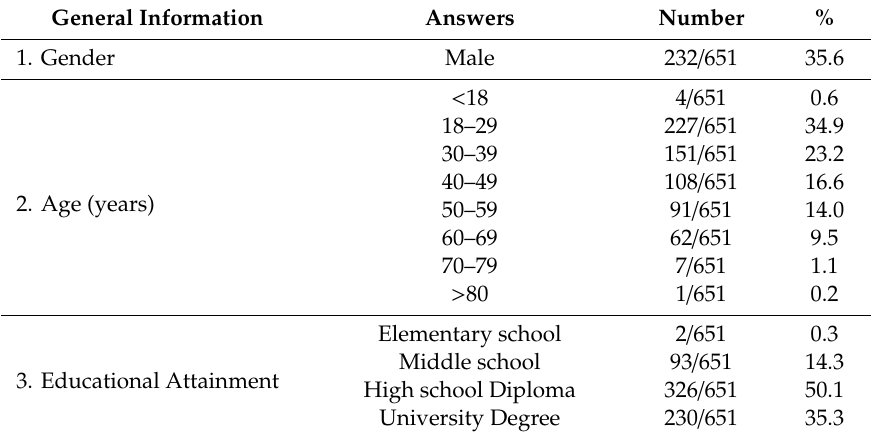
Table 3. Respondents general